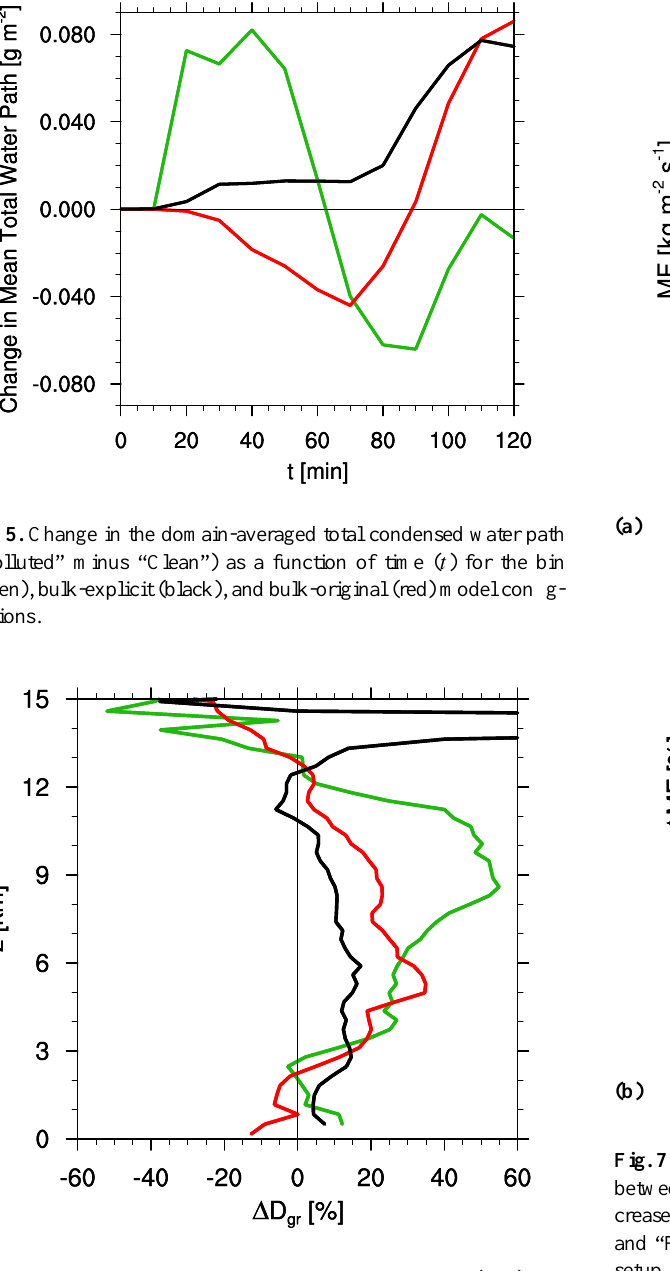
Fig. 6. Relative change in the mean graupel diameter ( D gr ) due to an increase in aerosol loading (“Polluted” minus “Clean”) aver- aged between 60 and 120min. Curves correspond to the bin (green), bulk-explicit (black), and bulk-original (red) model configurations.